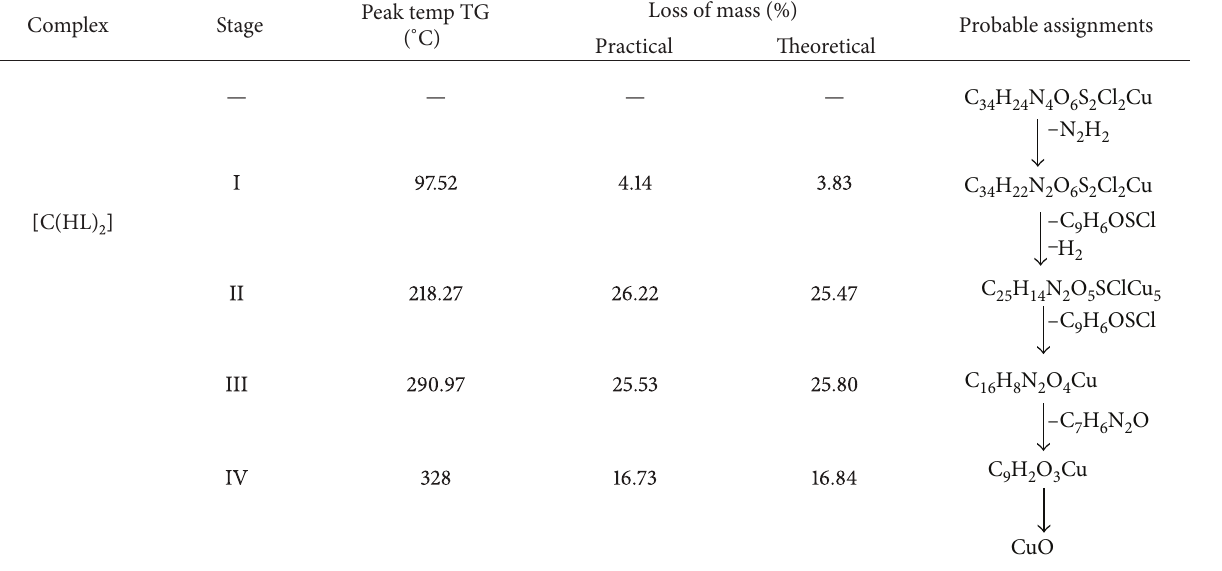
Figure 3: ESR spectrum of Cu(II) complex. Table 4: Thermal decomposition of Cu(II) complex of ligand